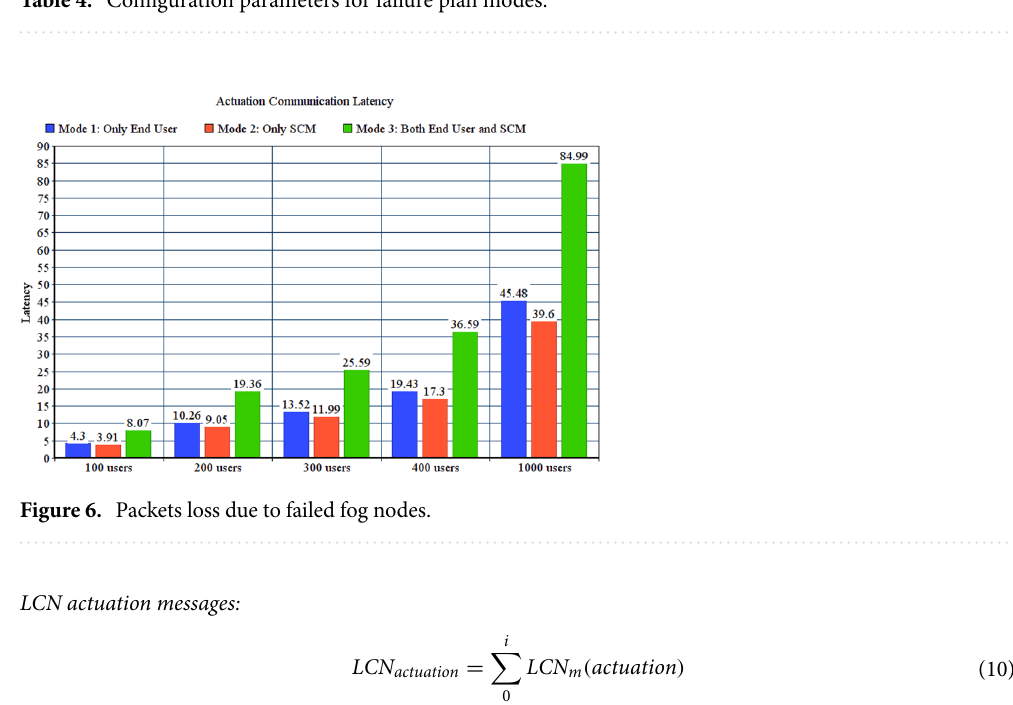
Table 4. Configuration parameters for failure plan modes.